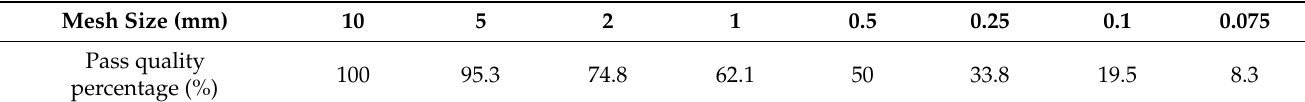
Table 1. Particle analysis results.